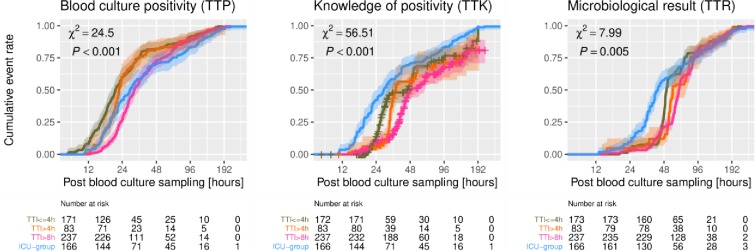
Kaplan-Meier estimates for TTP, TTK, and TTR.Cumulative event rates on logarithmic scale with 95% confidence bands (LAB group split according to TTI) with logrank test results.